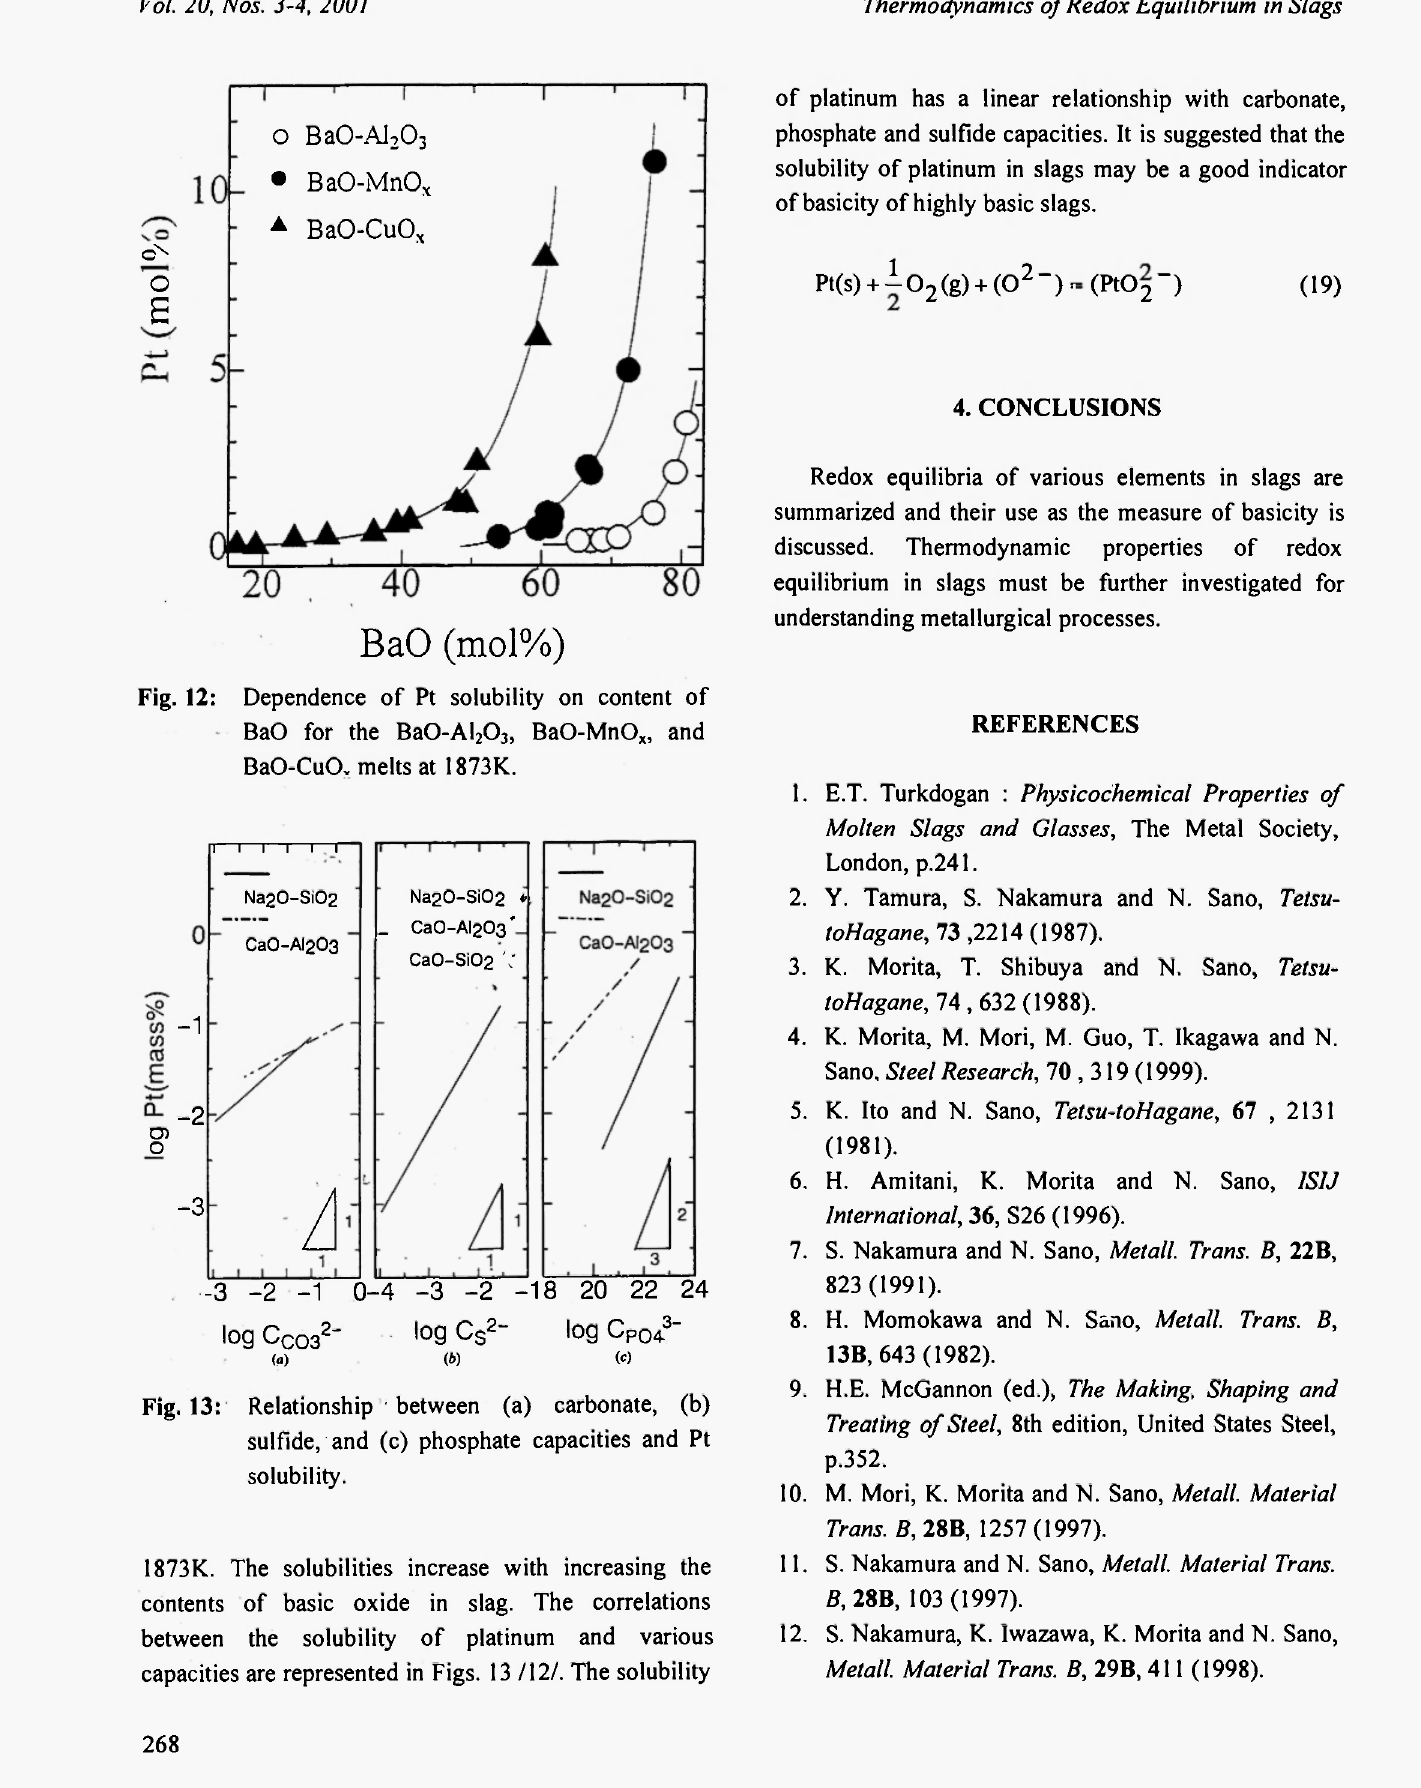
Fig. 12: Dependence of Pt solubility on content of BaO for the Ba0-Al 2 0 3 , BaO-MnO x , and BaO-CuO, melts at 1873K.